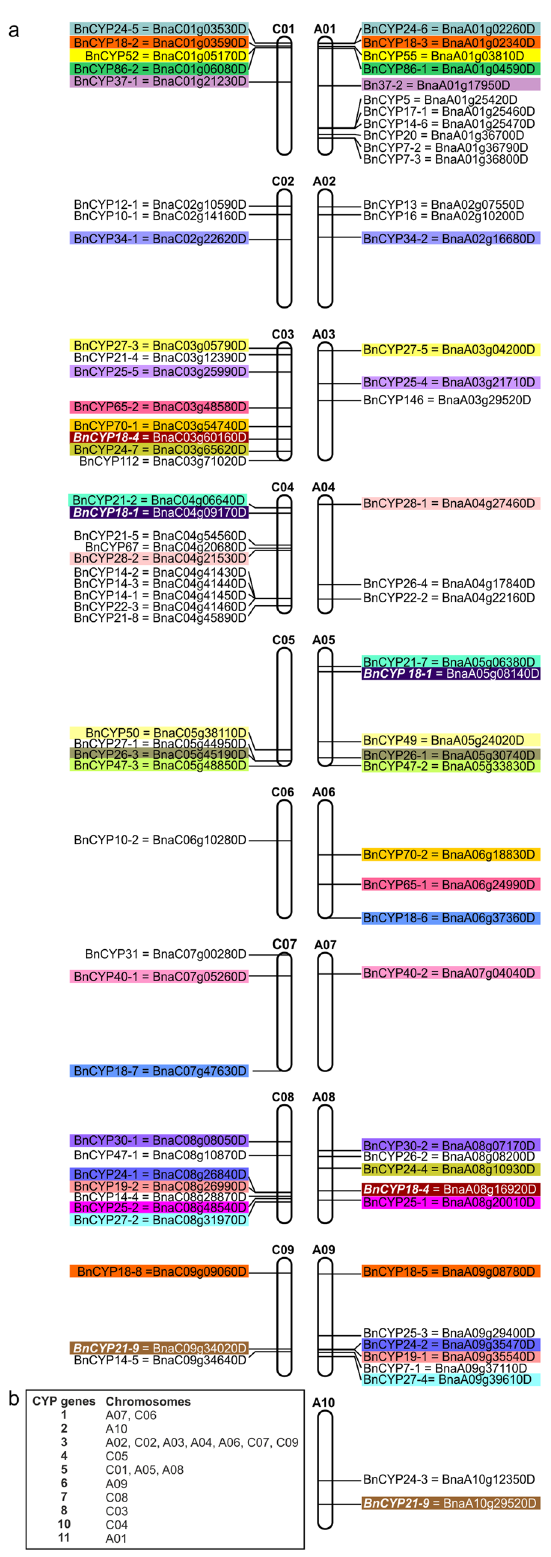
Figure 4. Genomic distribution of cyclophilin genes on B. napus chromosomes. ( a ) Chromosomal locations of BnCYP genes are indicated based on the information provided by the Brassica napus Genome Browser. Highlighted by identical colours are BnCYP genes which encode protein isoforms. Genes encoding identical proteins are written in italics and white colour. ( b ) Summary of the number of BnCYP genes encoded on each